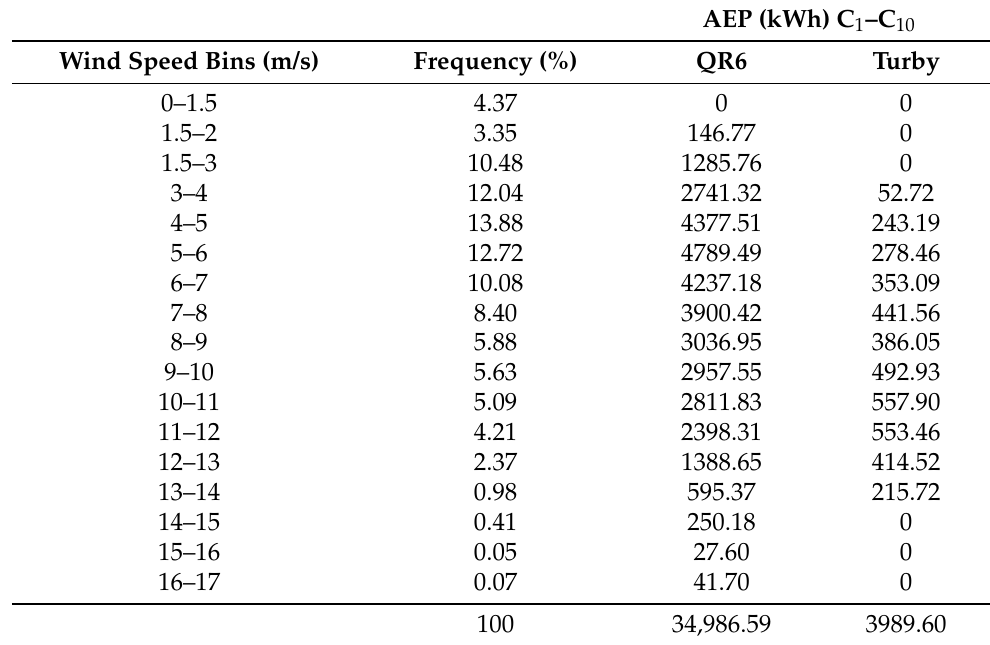
Table 8. AEP of a single turbine for individual wind speed bins (typology of a turbine on the roof of a building).